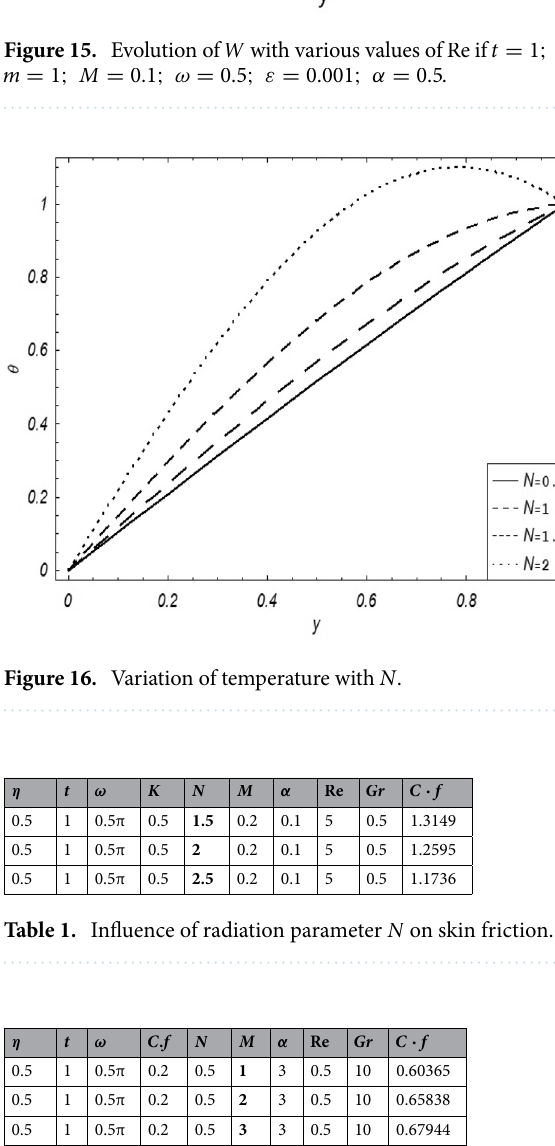
Table 2. Influence of magnetic parameter M on skin